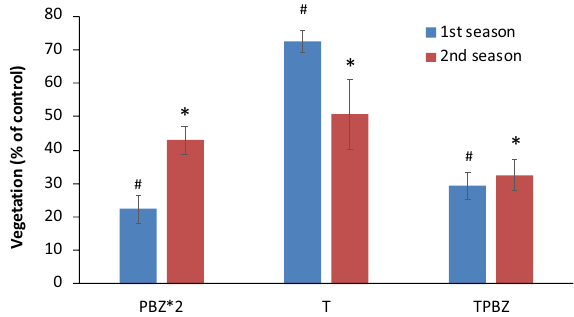
Figure 10. Amount of vegetation relative to control in treated plots as measured by extracting values of RGB variations using image analysis of the plots. PBZ*2 is 2 g of PBZ/m 2 (neat); T is 2 g of PBZ/m 2 (in granules); TPBZ is 2 g PBZ/m 2 (in granules) with 1 g PBZ/m 2 (neat). The different treatments demonstrated a statistically significant growth retardation (ANOVA, n = 3, p < 0.01); #, * indicate statistically significant difference compared to season 0 (control) for season 1 and season 2 measurement data, respectively (n = 3, p <